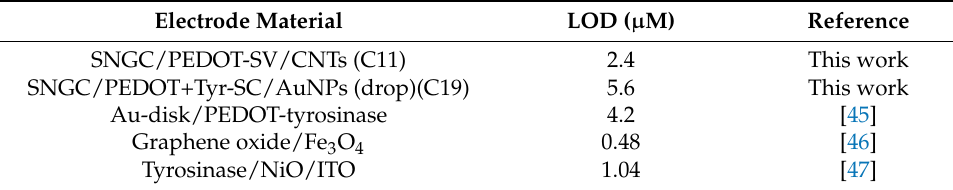
Table 3. Figures of merit obtained with different electrochemical